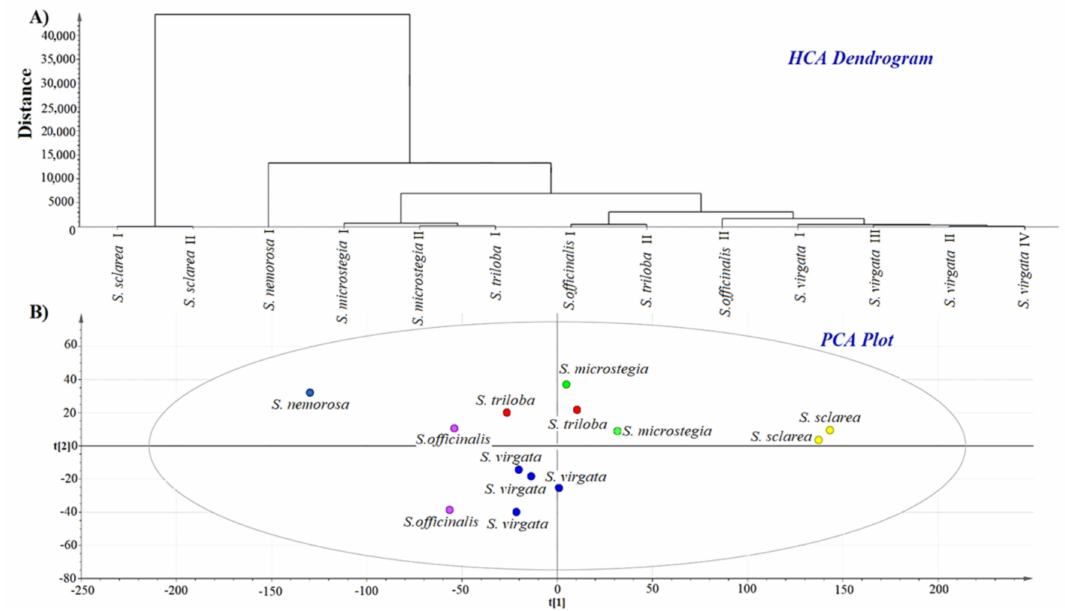
Figure 2. Hierarchical cluster analysis (HCA) of volatile compounds of the seed samples of Salvia species ( A ). Principal component analysis (PCA) of volatile compounds of the seed samples of Salvia species ( B